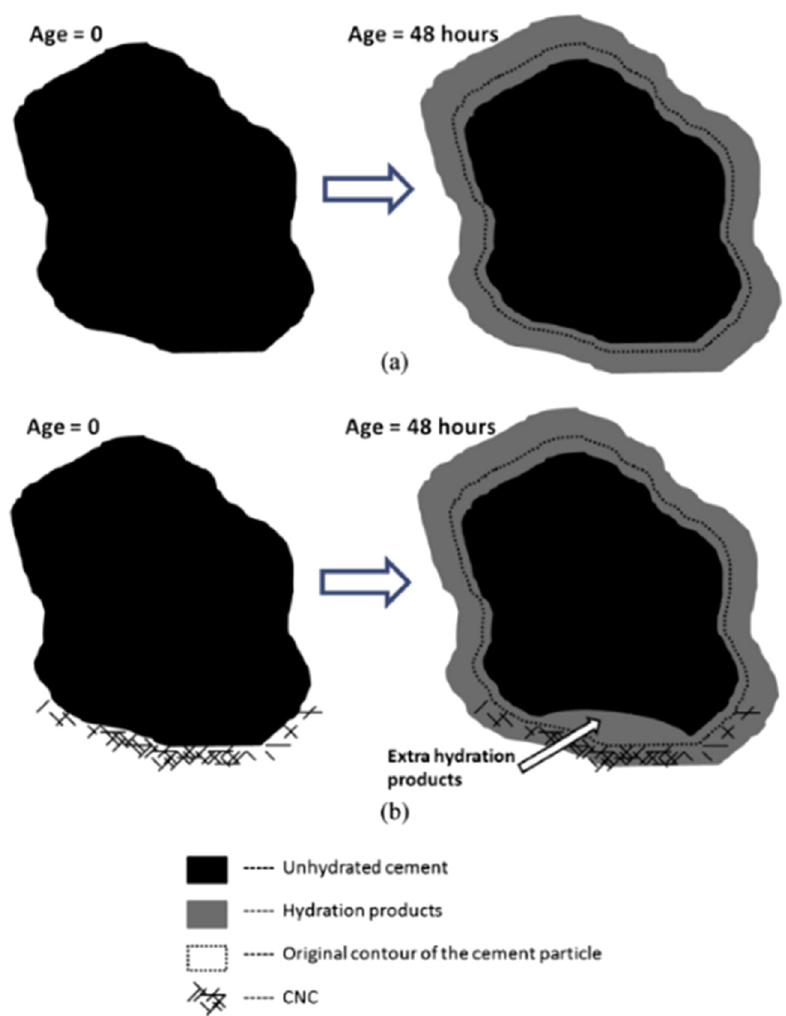
Figure 26: A schematics illustration of the proposed hydration products forming around the cement grain from the age of 0 – 48 h in the ( a ) plain cement and ( b ) cement with CNCs on a portion of the cement particle showing short - circuit - di ff usion mechanism [ 42 ] ; Copyright 2015, Elsevier